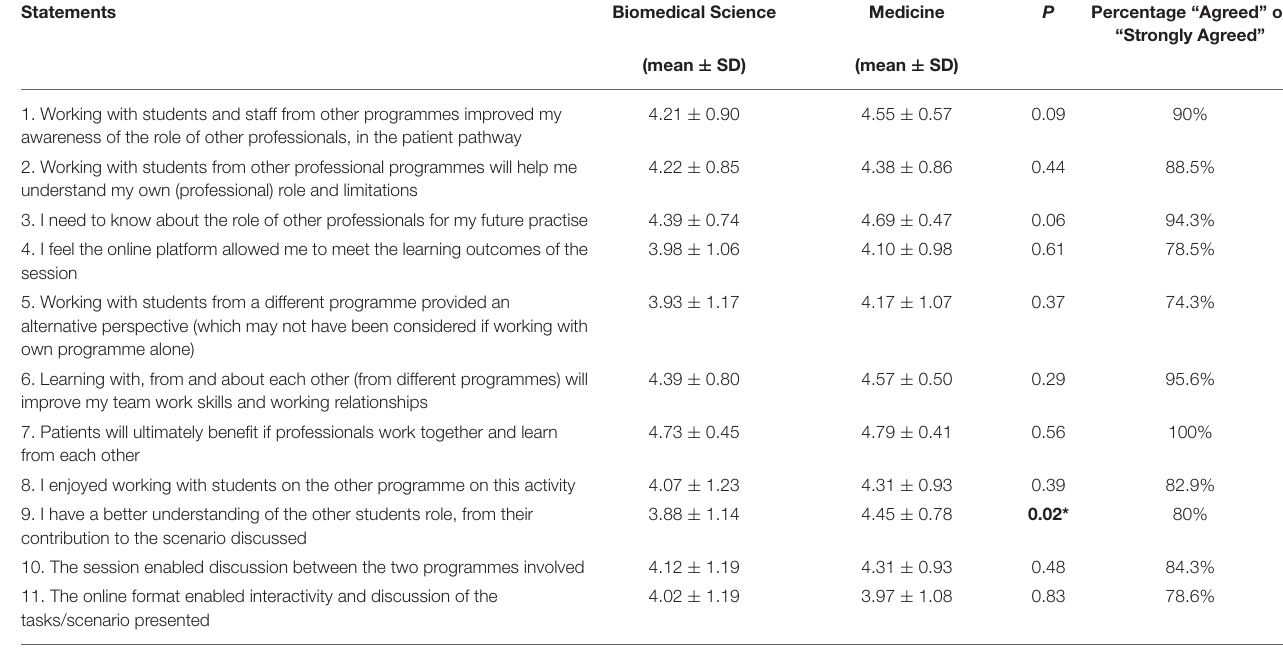
TABLE 1 | Student survey responses relating to the IPL workshop ( n =